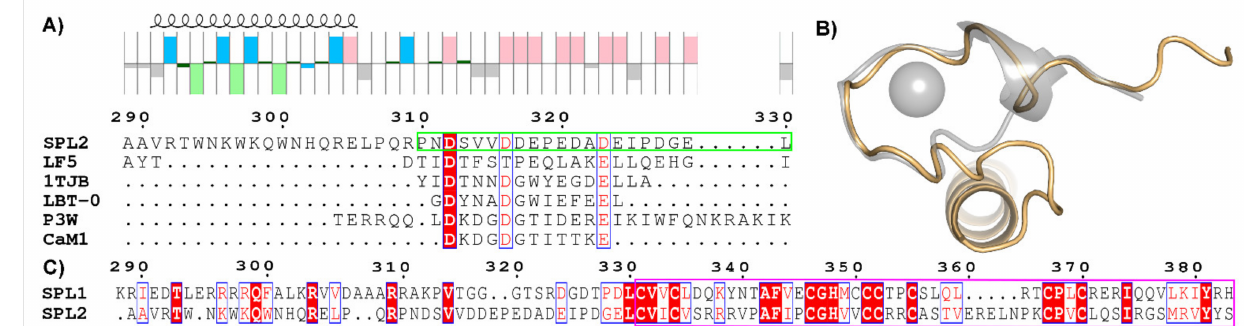
Figure 1. Comparison of sequences and structures of SPL2 and lanthanide-binding peptides. ( A ) Sequence alignment of the part of SPL2 showing its cytosolic region without RING, LF5—lanthanide finger 5 [11], 1TJB—high-affinity LBT peptide [10], LBT-O—peptide optimized for terbium luminescence [12], and P3W—DNA-dependent MRI contrast agent [12]. For comparison, one of the Ca2+-binding sites of calmodulin is shown (CaM1). The predicted disordered region is outlined in light green. A hydropathy plot of SPL2 revealing the position of basic (blue), acidic (pink), aliphatic (gray), polar (dark green), and aromatic (light green) amino acid residues. Predicted secondary structures of SPL2 are depicted on top. The predicted structure of the MBP-SPL2cyt fusion protein is shown in Figure A1 (Appendix A). ( B ) Structural alignment of the LBT–Tb3+ complex (1TJB, gray) and the predicted cytosolic region of SPL2 (gold). Terbium ions bound to 1TJB are shown as a gray sphere. ( C ) Amino acid sequence alignment of the cytosolic domain of the SPL1 and SPL2 proteins. RING domains are boxed in